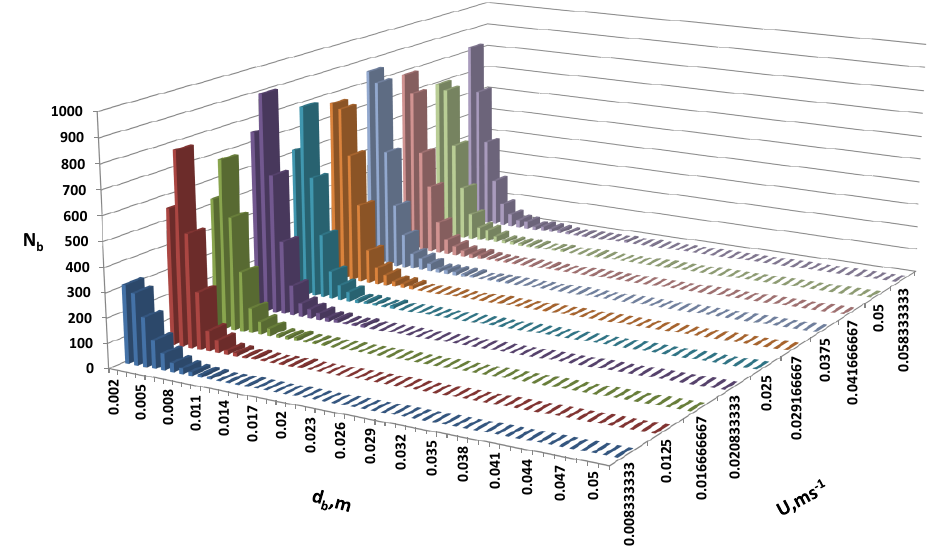
Figure 12. Variation of BSD with U at H c = 0.24 m.